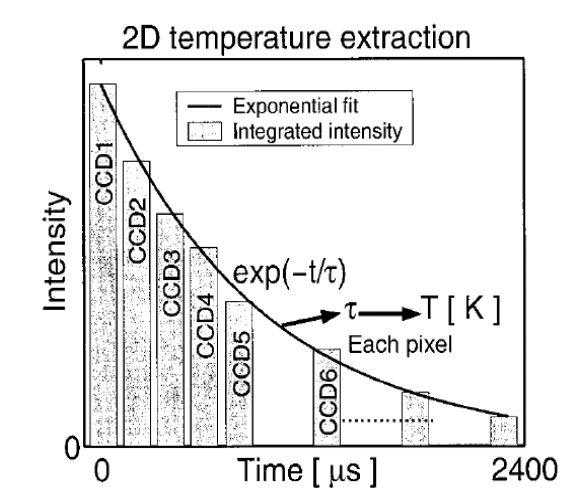
Figure 15. Curve fit for a single pixel from a series of images obtained from 8 CCD detectors [40].